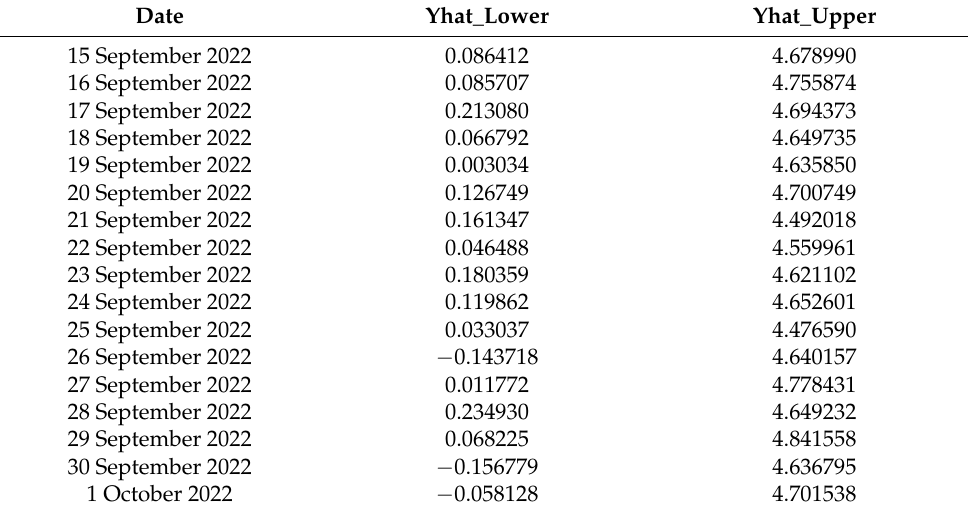
Figure 13. Future prices of the EOS cryptocurrency. Table 8. Results of the EOS data set for the last 15 days. Table 8. Results of the EOS data set for the last 15 days.